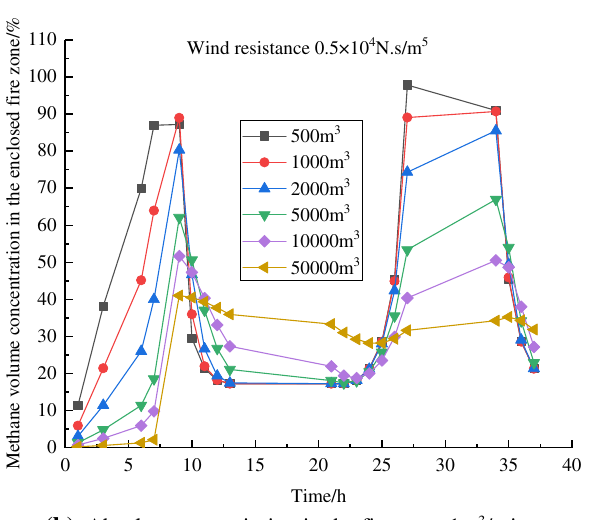
(a) Absolute gas emission in the fire zone 10m 3 /min